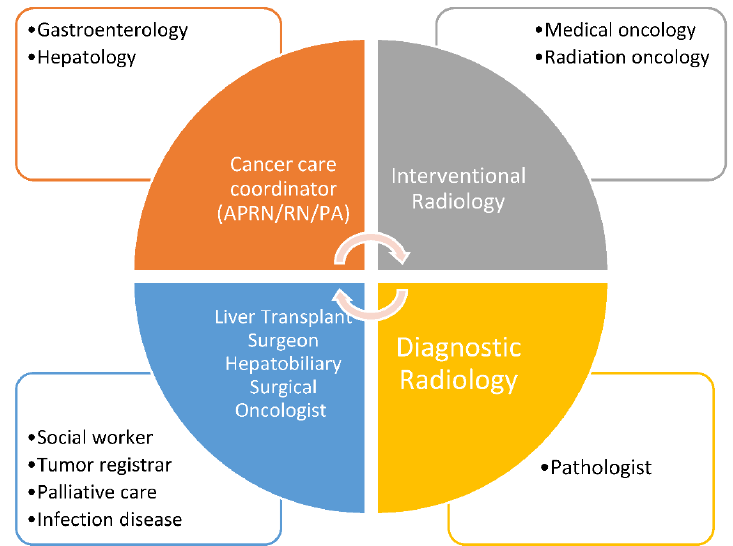
Figure 2. Proposed disciplines to create MDTB to care for liver cancer patients.